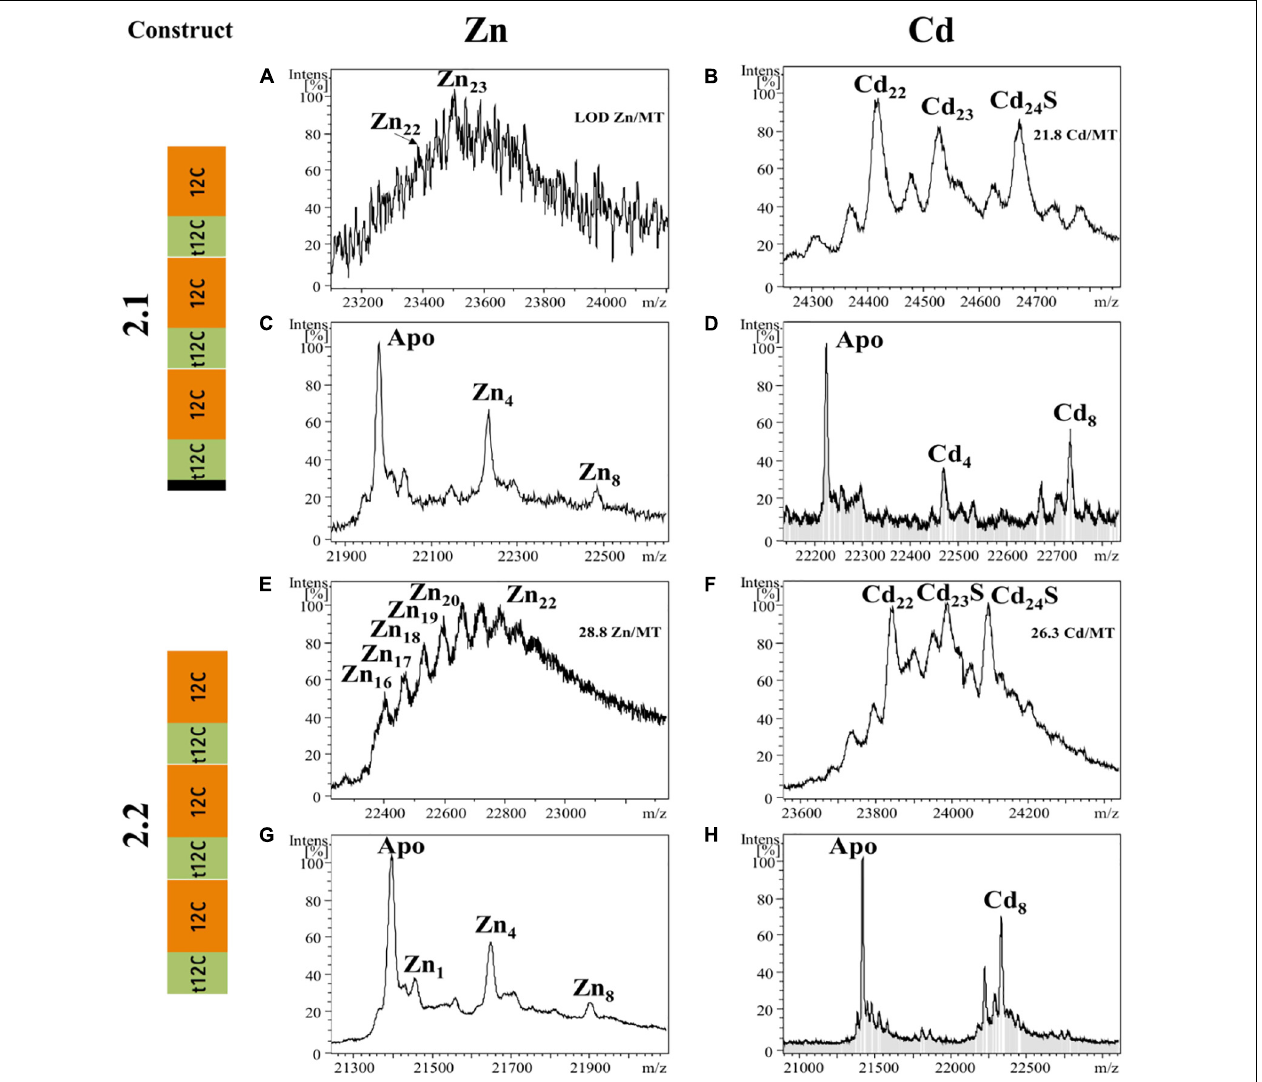
FIGURE 3 | Deconvoluted ESI-MS spectra recorded at pH 7.0 (A,B,E,F) and pH 2.4 (C,D,G,H) of OdiMT2 constructs 2.1 (A–D) and 2.2 (E–H) bioproduced with Zn (A,C,E,G) or Cd (B,D,F,H) . Y -axis represents the relative intensities of the peaks while the X -axis represents the m/z ratio equivalent to the MW (Da). The metal-to-protein ratio obtained by ICP-AES is included on the top right of panels (A,B,E,F) . It is indicated those cases in which the sample concentration was lower than the limit of detection